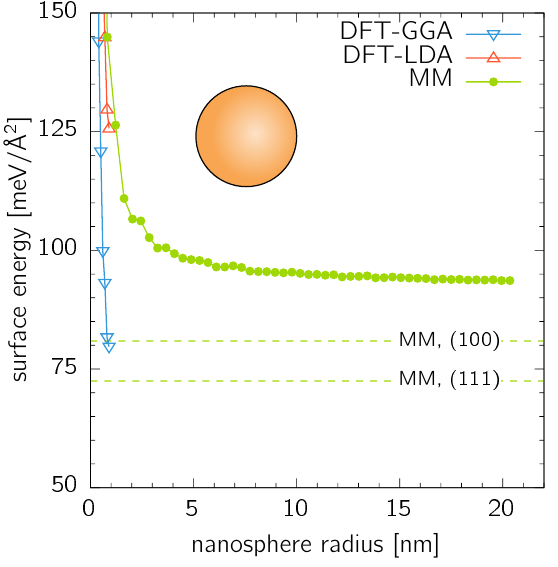
Figure 2. Surface energy of nanocubes Figure 3. Surface energy of nanospheres Figure 3. Surface energy of nanospheres calculated by DFT and MM. The dashed lines are the MM calculated by DFT and MM. The calculated calculated by DFT and MM. The dashed lines values for single-orientated ( 100 ) and ( 111 ) surfaces as listed in Table datapoints were fitted with Equation (3). The are the MM values for single-orientated ( 1 0 0 ) dashed lines are ( 1 0 0 ) surface energies as and ( 1 1 1 ) surfaces as listed in Table 1. listed in Table 1.